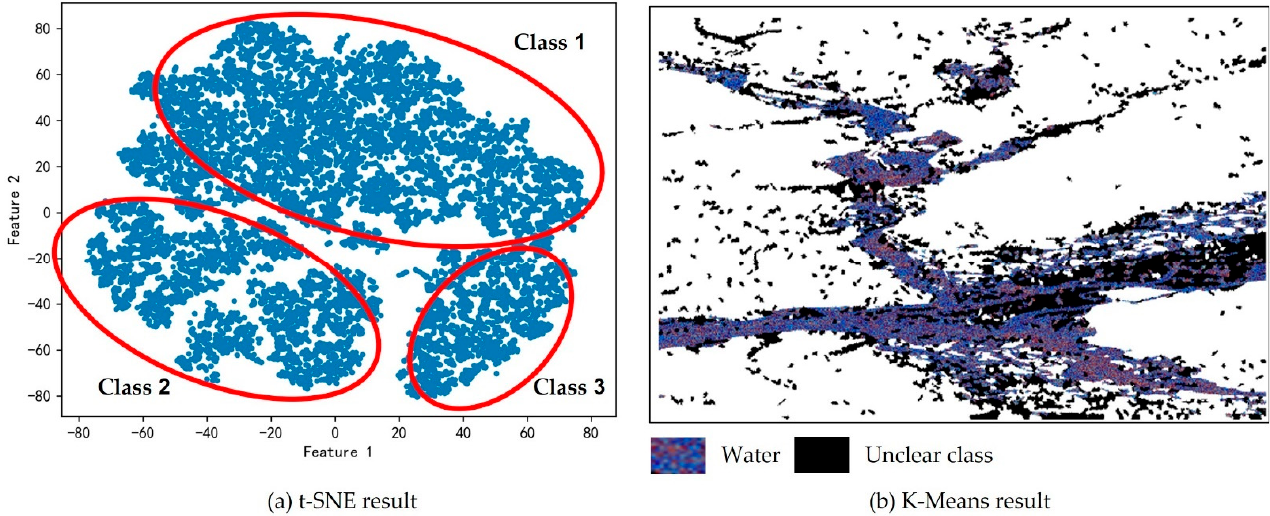
Figure 8. ( a ) Visualization of features after t-SNE operation—three classes were acquired; ( b ) pre- classification result through K-Means.